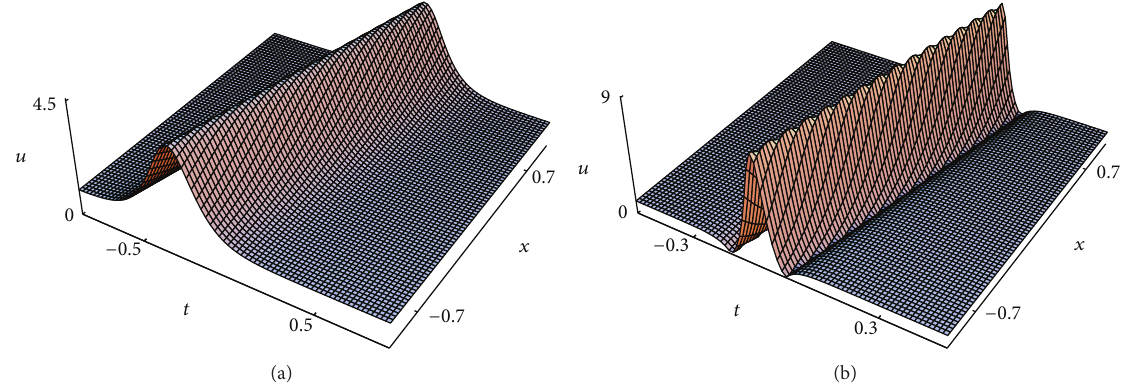
Figure 2: Evolution of the solutions of (25). (a) Bright soliton: parameters are 𝛼 = 1 , 𝛽 = 1 , 𝑎 1 = 1 , 𝑏 0 = 2 , and 𝑘 = 2 . (b) A bright soliton in collision with two dark solitons: parameters are 𝛼 = 1 , 𝛽 = 1 , 𝑎 1 = 1 , 𝑏 0 = −1 , and 𝑘 = −3 .